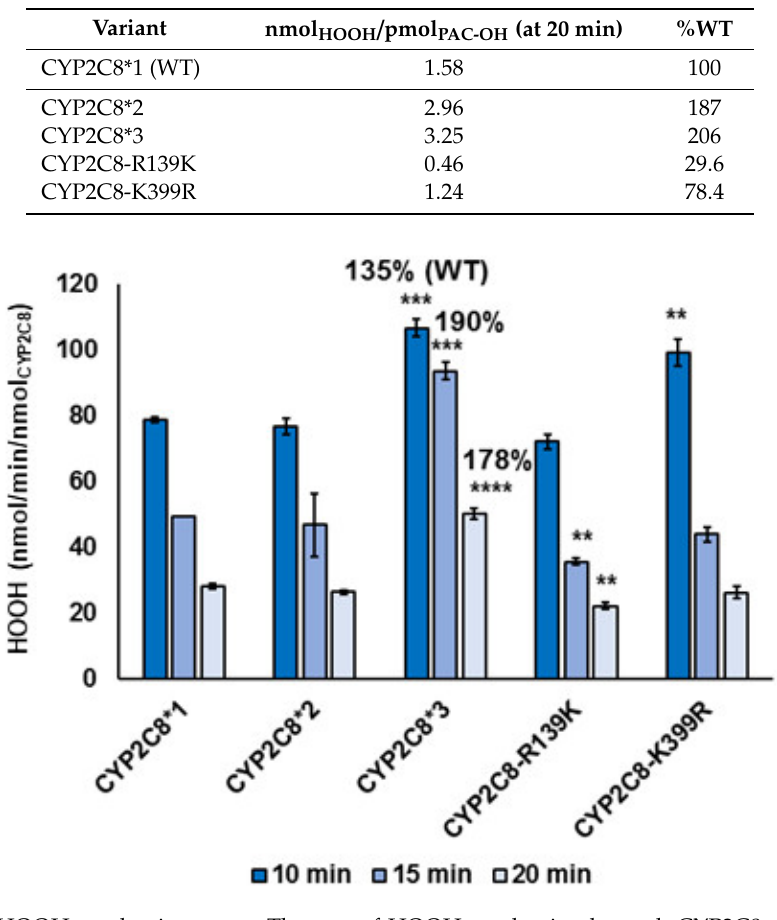
Figure 3. HOOH production rates. The rate of HOOH production by each CYP2C8 variant was measured using an Amplex Red peroxidase kit at 10, 15, and 20 min reaction times, in the presence of 70 µ M PAC. Error represents the SEM of 3–4 experiments. Statistical significance was determined by comparing experiments to their respective WT controls. ** p < 0.01; *** p = 0.0001; **** p < 0.0001.